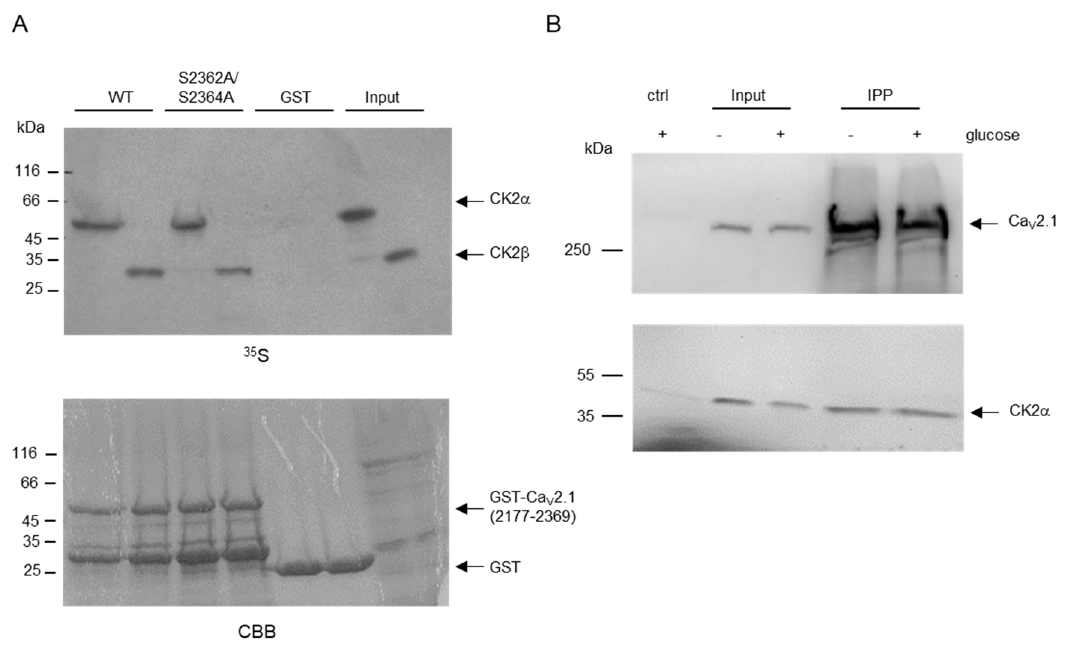
Figure 2. CK2 binds to Ca V 2.1. ( A ) GST pull-down analysis of Ca V 2.1 and CK2. Equal amounts of GST–Ca V 2.1 (2177-2369) wild-type and double-mutant S 2362 A / S 2364 A coupled to GSH sepharose were incubated with in vitro-translated and [ 35 S]-methionine-labeled CK2 α and CK2 β proteins. Proteins bound to the a ffi nity matrix were subjected to SDS polyacrylamide gel electrophoresis, stained with Coomassie Brilliant Blue (CBB), followed by autoradiography ( 35 S). A representative autoradiography and a corresponding CBB staining are shown. ( B ) Co-immunoprecipitation of Ca V 2.1 and CK2 from INS-1 cells. Five milligrams of extract from cells grown with 0 mM (-) or 10 mM ( + ) glucose were pre-cleared twice from non-specific binding proteins with protein G sepharose beads (ctrl). After the centrifugation of the beads, the supernatants were incubated with a rabbit Ca V 2.1 antibody coupled to protein G sepharose overnight. Bound proteins were extracted with sample bu ff er, separated in a 10% SDS polyacrylamide gel and blotted to a PVDF membrane. Ca V 2.1 and CK2 α subunit were detected with a rabbit monoclonal antibody directed against Ca V 2.1 or the mouse monoclonal antibody 1A5 against CK2 α . Ctrl: proteins bound to protein G sepharose; input: 2% of whole protein extract used for immunoprecipitation; IPP: proteins immunoprecipitated with Ca V 2.1-specific antibody.